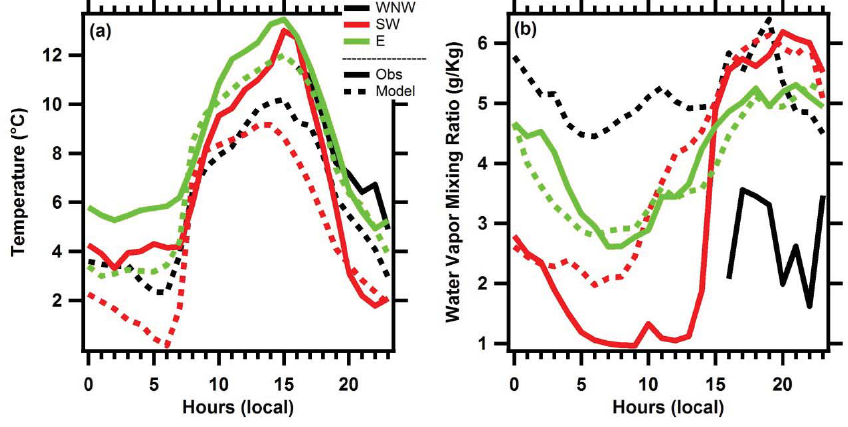
Figure 3. Measured (solid line) and simulated (dashed) daily trends in a) temperature and Fig. 3. Measured (solid line) and simulated (dashed) daily trends in (a) temperature and (b) water vapor mixing ratios for the three cases b) water vapor mixing ratios for the three cases related to air mass origin, i.e. east related to air mass origin, i.e. east (E, green), southwest (SW, red) and west northwest (WNW, (E, green), southwest (SW, red) and west northwest (WNW, black).